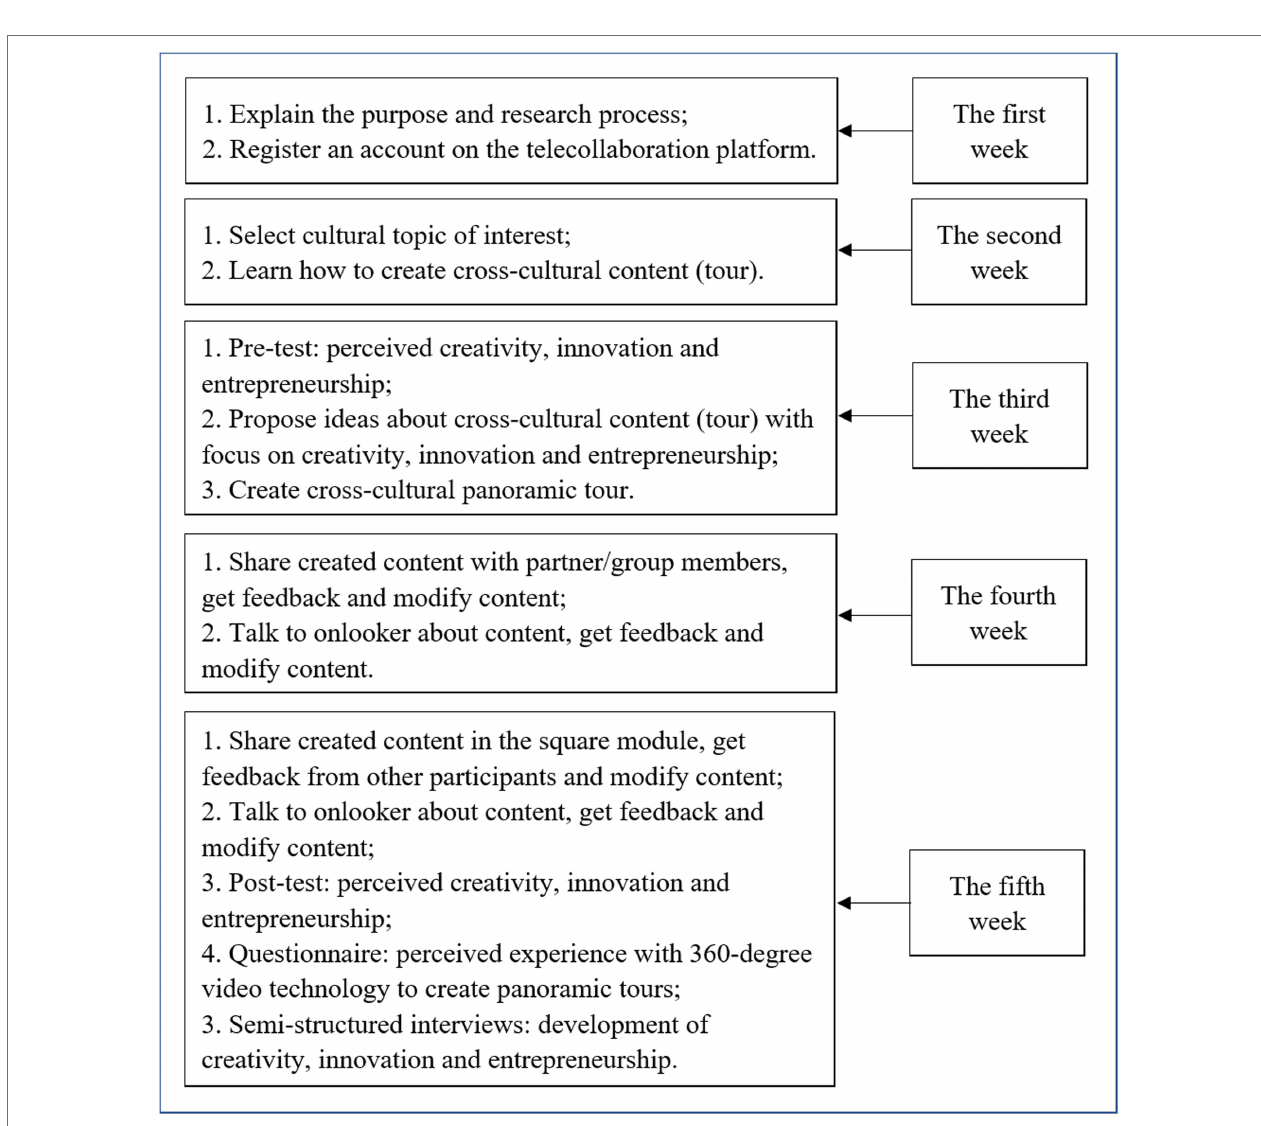
FIGURE 1 | Research